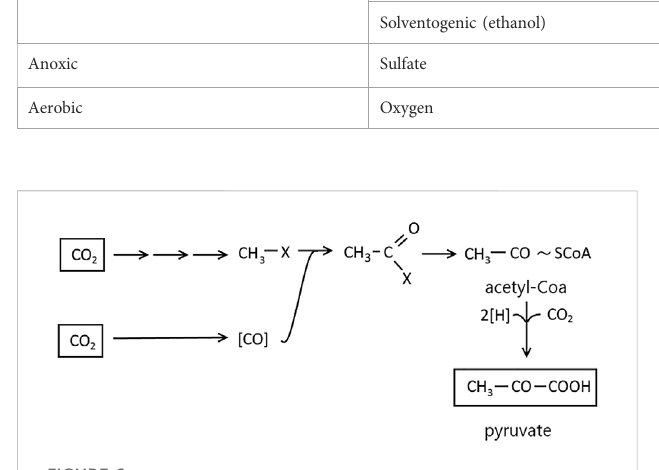
FIGURE 6 Autotrophic CO 2 fi xation in reduction acetyl-CoA pathway. Figure redrawn after reference (Schlegel,